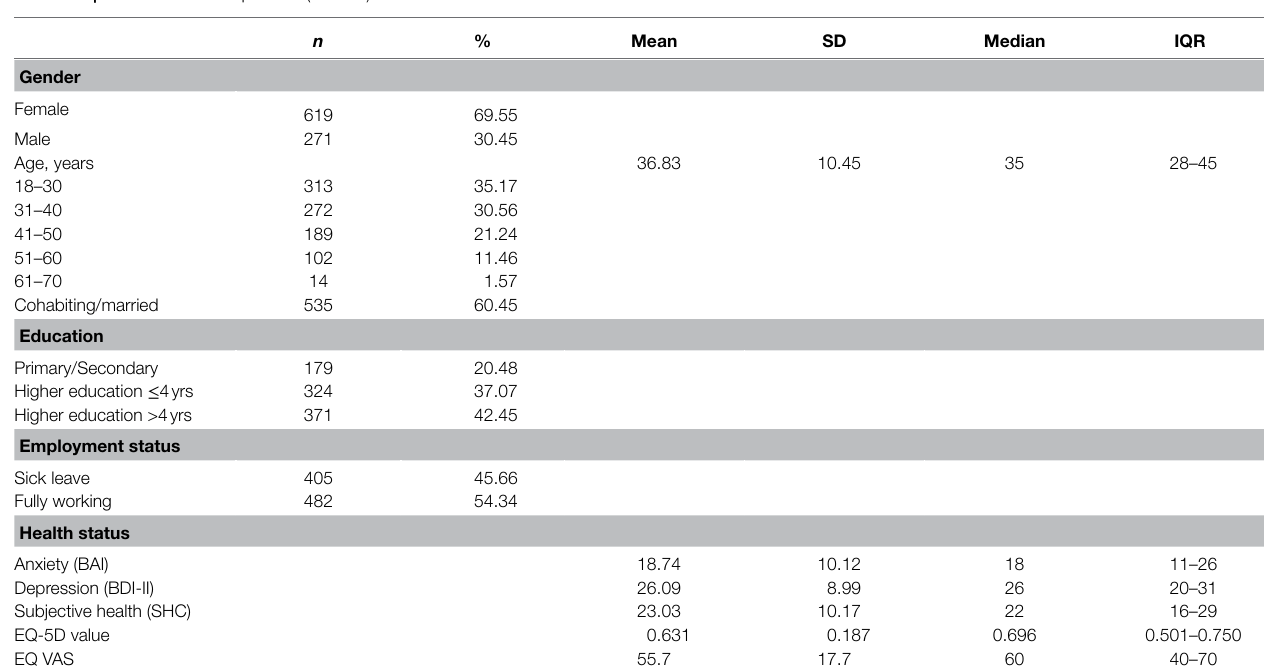
TABLE 1 | Characteristics of patients ( N =